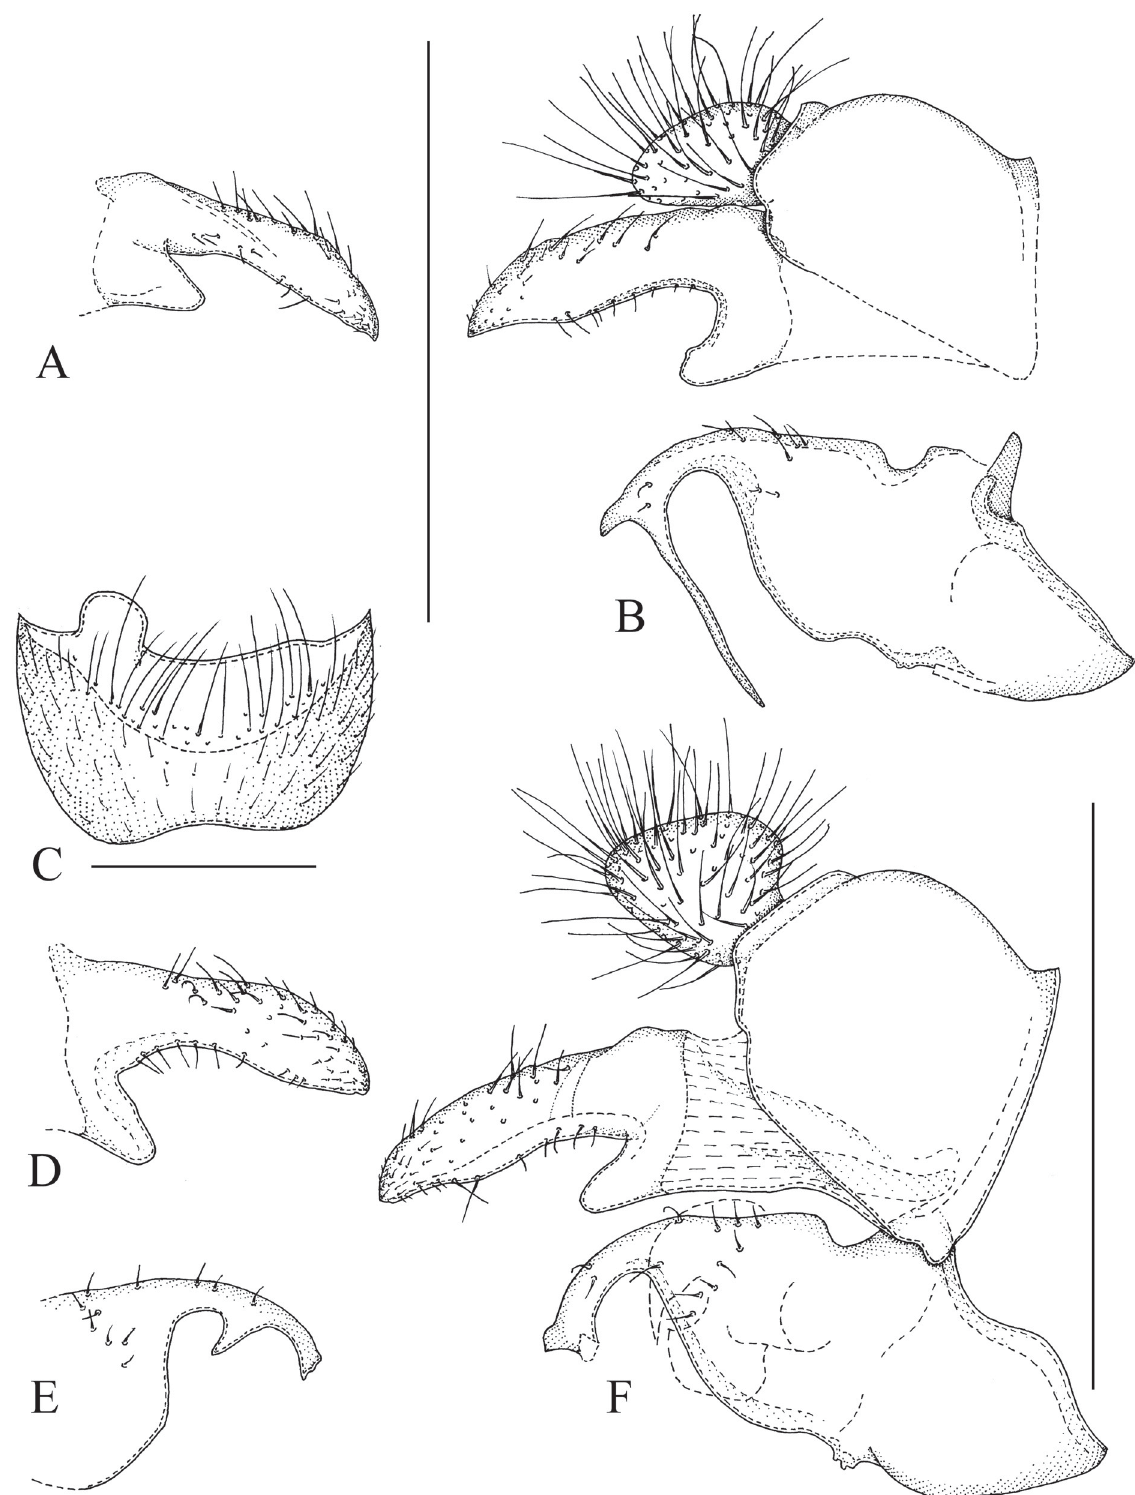
Fig. 78. Sphegina (Asiosphegina) prolixa sp. nov., holotype, ♂ (A–B) and parat ype, ♂ (C–F). A, D . Left surstylus, lateral view. B, F . Genitalia, right side, lateral view. C . Sternum IV, ventral view. E . Left superior lobe, lateral view. Scale bars = 0.5